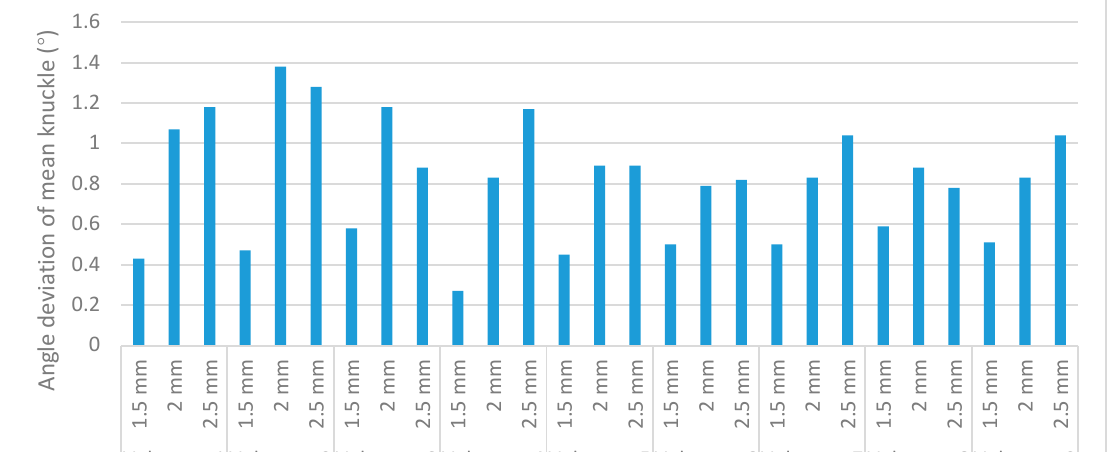
From Tables 2 and 3, the deviations from the mean knuckle angle at different scale markers, shown in Figure 11, can be calculated.